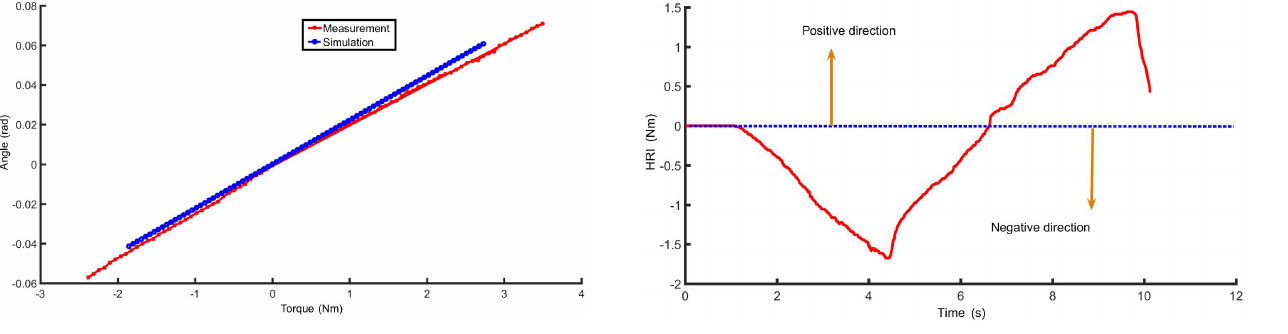
Figure 9. Calibration experiment result. Simulation data are repre- sented with circle dots and experimental data are represented with star dots.